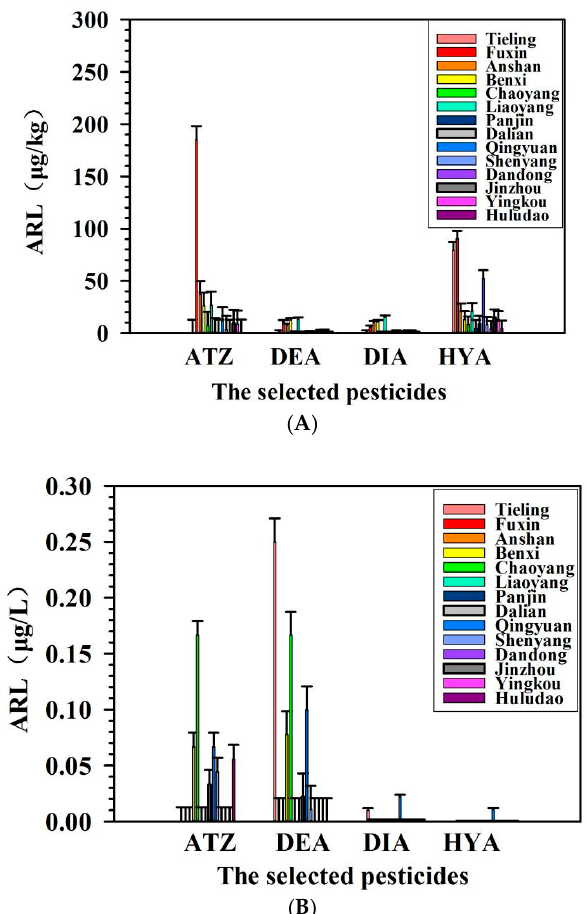
Figure 4. Average residual concentration of the analytes in the collected samples from different regions of Liaoning in 2018. ( A ) soil; ( B ) groundwater.